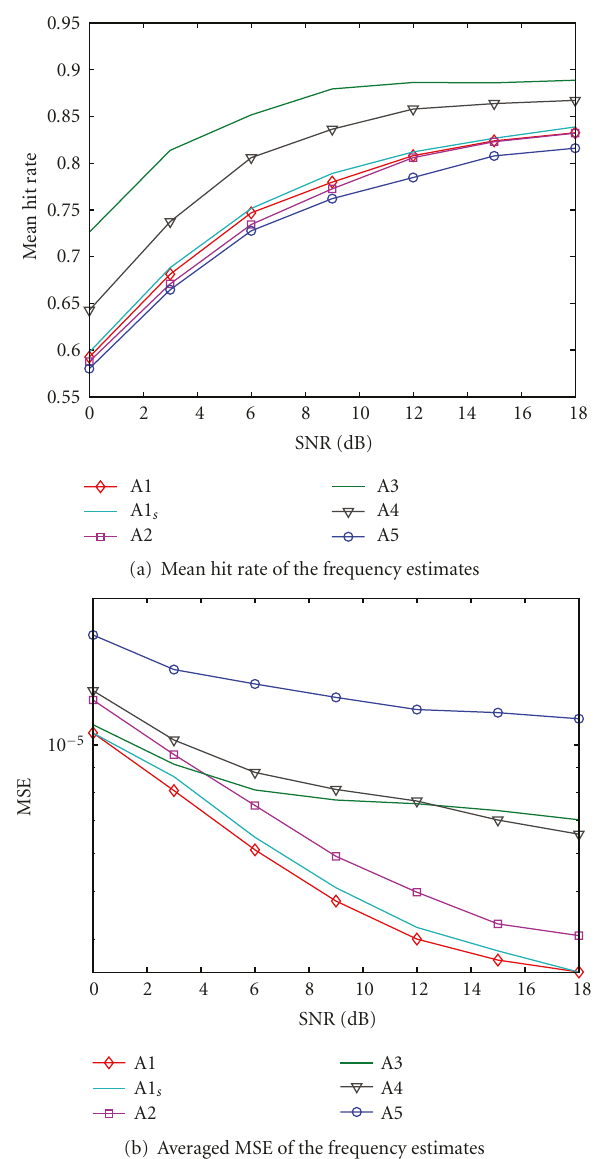
Figure 4: The averaged hit rate (a) and MSE (b) versus the SNR in the algorithms A1–A5 when p = 10, L = 50, and M = 60 for A1, A1 s , A3, M = 120 for others.